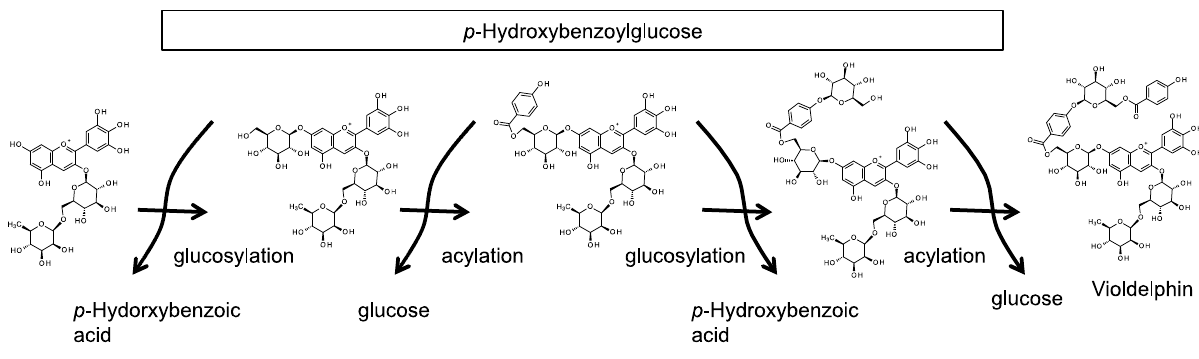
Figure 7. Concatenated units in violdelphin synthesized in a step-by-step reaction utilizing acyl-glucose as both glucosyl and acyl donor in